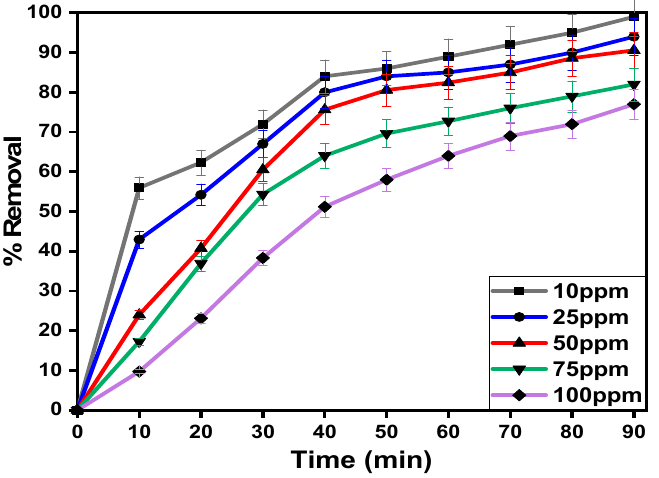
Figure 9. Effect of initial concentration of diazinon on removal process at pH = 7, contact time = 40 min, adsorbent dosage = 0.5 g/L, temperature = 22 ◦ C, and agitation speed = 300